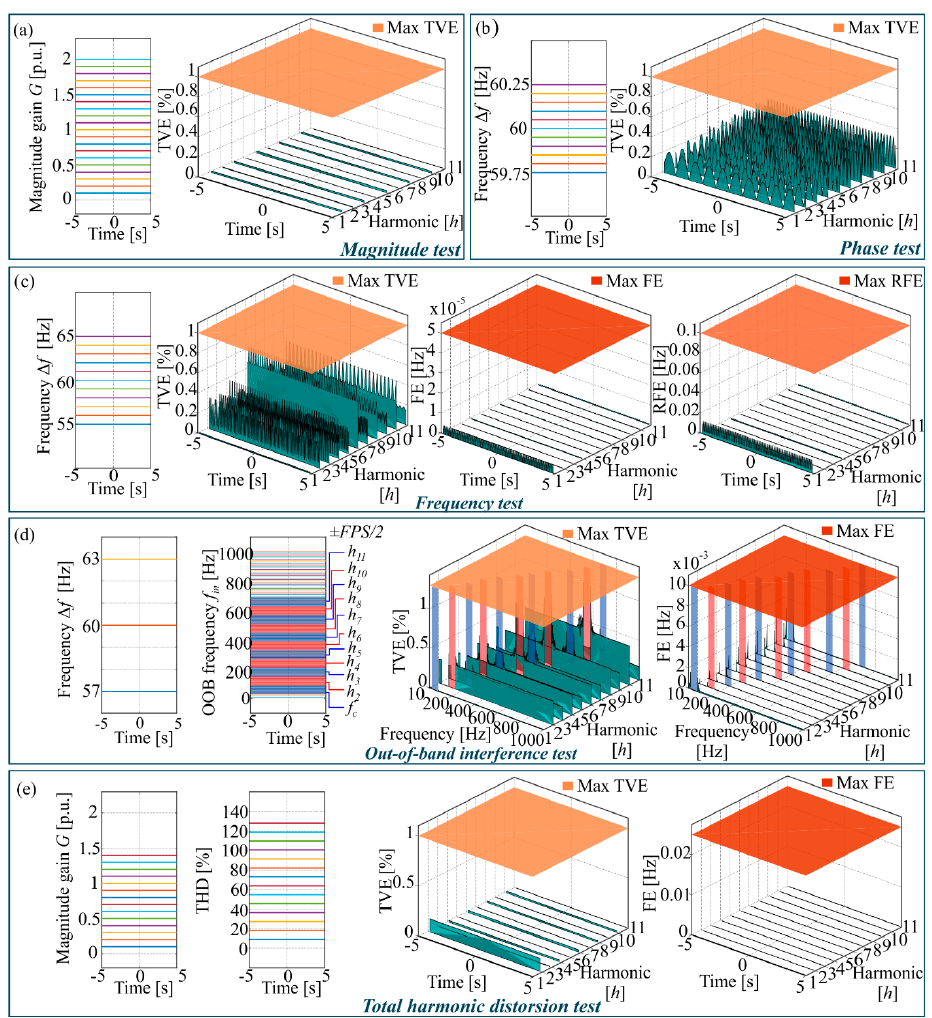
Figure 4. Steady-state tests: ( a ) magnitude test, ( b ) phase test, ( c ) frequency test, ( d ) out-of-band test, and ( e ) total harmonic distortion test.